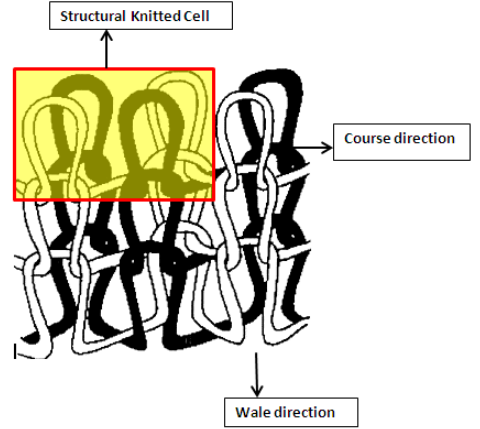
Figure 3. Schematic diagram of Interlock fabric showing a structural knitted